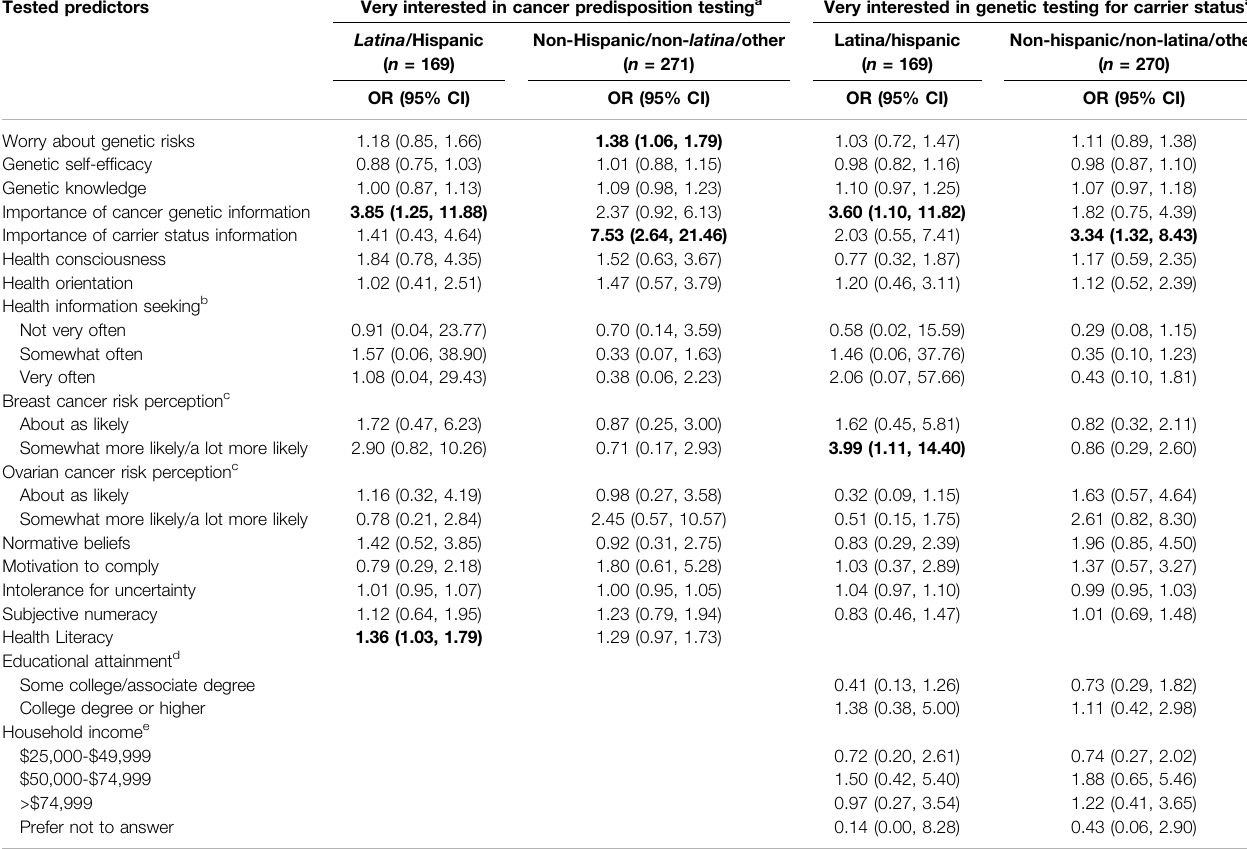
TABLE 8 | Multivariable logistic regression models, strati fi ed by ethnicity, showing predictors of being very interested in cancer predisposition testing and carrier screening. Tested